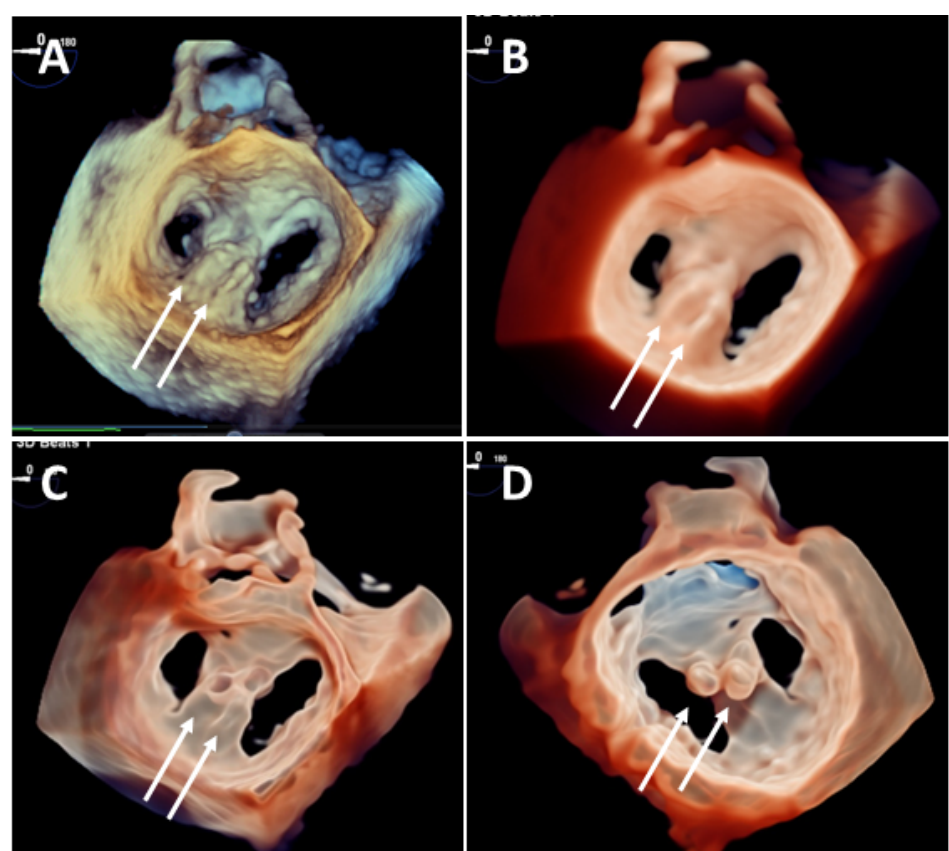
Figure 5. Comparisons of the standard 3DTEE ( A ), transillumination ( B ) and transparency ( C , D ) in the evaluation of 2 clips implanted side by side in the A2-P2 region (arrows). The perspective in ( A – C ) is the surgical view while in ( D ) is the ventricular view. Transillumination with addition of glass rendering allows an excellent definition of the 2 orifices and the more precise identification of clip location.